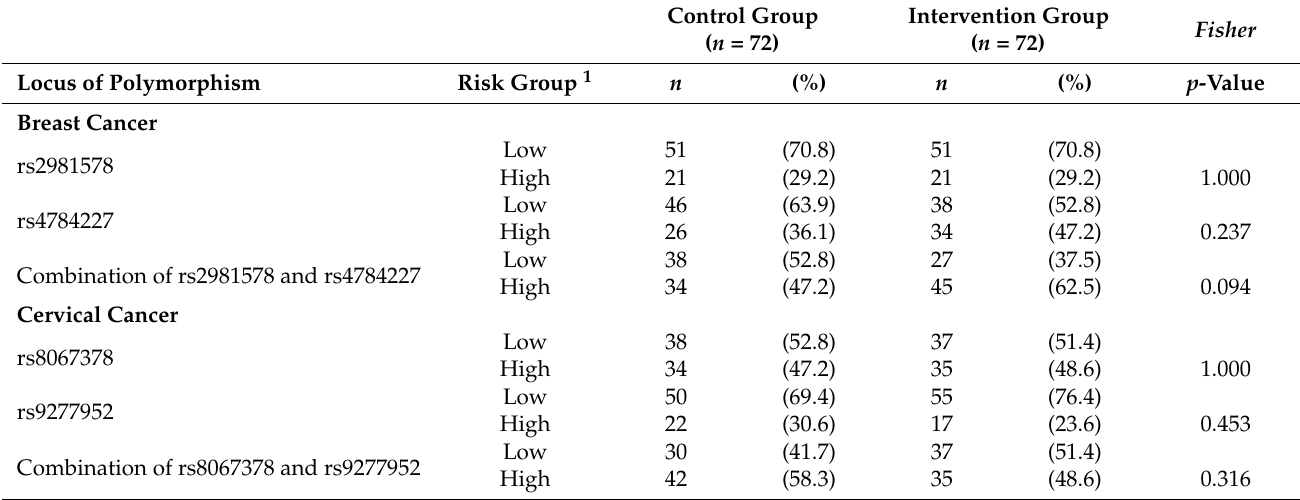
Table 2. Distribution of participants according to genetic risk group for breast and cervical cancer in Okazaki, Japan, 2018.